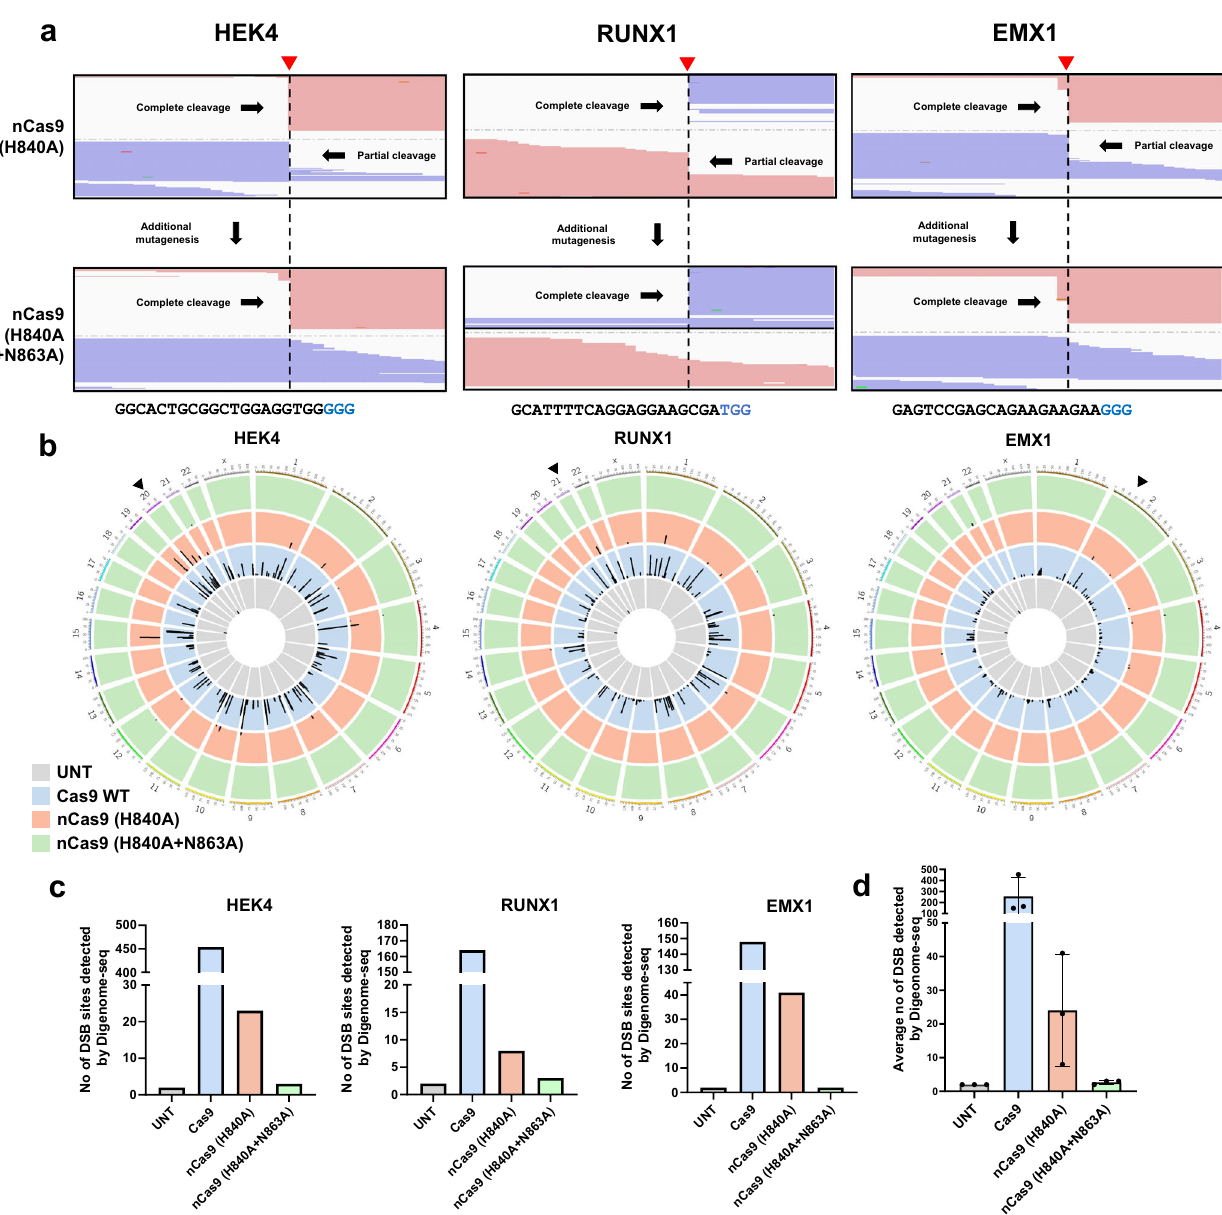
Fig. 2 | Target strand cleavage catalyzed by nCas9 (H840A) can be reduced by an additional mutation at N863 in the HNH domain. a WGS results at on-target sitesvisualizedwiththeIGVviewer.GenomicDNAisolatedfromHEK293Tcellswas subjected to in vitro digestion with puri fi ed nCas9 (H840A) and nCas9 (H840A+ N863A) proteins with appropriate sgRNAs. The addition of an N863A mutation to nCas9 (H840A) removed its target strand-cleaving function, as seen at three dif- ferent loci. b Circos plots showing genome-wide DSBs detected by Digenome-seq.